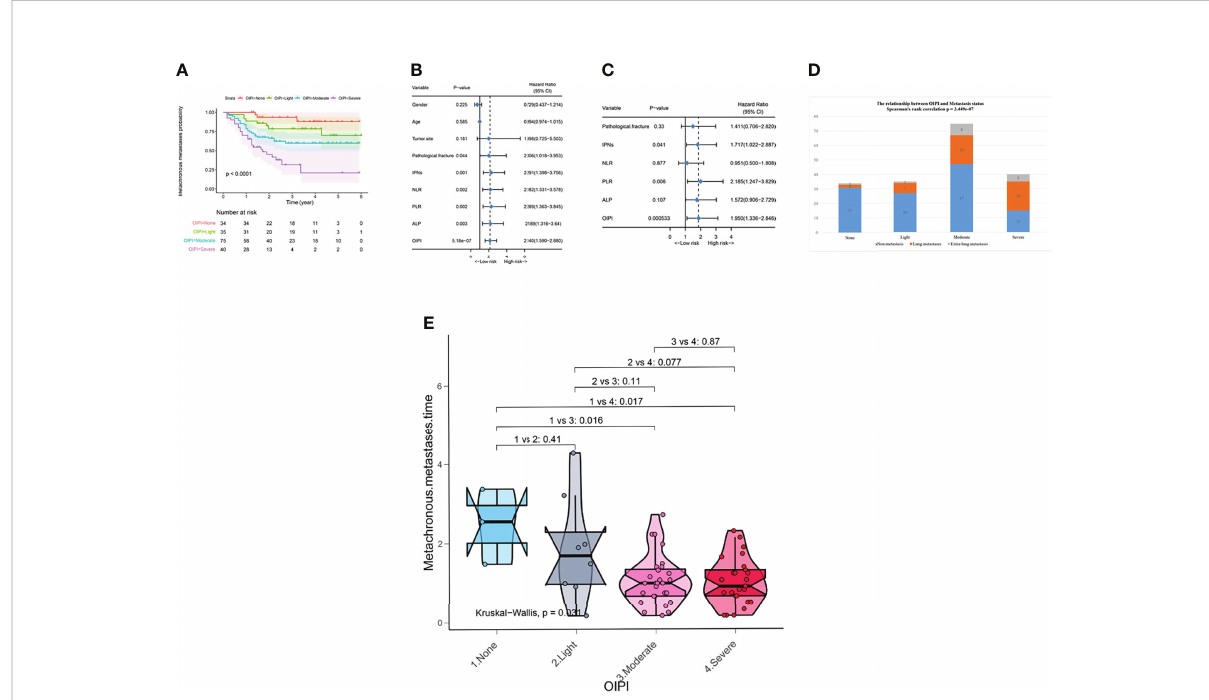
FIGURE 2 Effect of the OIPI in predicting metachronous metastasis, metastatic sites, and metastatic time in 184 patients. (A) OIPI divided 184 osteosarcoma patients into four groups. According to the logistic regression analysis, the differences between four OIPI groups in the metachronous metastasis probability were signi fi cant. (B) Forest plot showing the results of univariate Cox regression analysis of hematological markers and clinical features in 184 osteosarcoma patients. (C) Forest plot showing the results of multivariate Cox regression analysis of hematological markers and clinical features in 184 osteosarcoma patients. (D) Spearman ’ s rank correlation test demonstrated that OIPI was related to metastatic sites. (E) Kruskal – Wallis test demonstrated that there was a difference in metastatic time among four groups (P = 0.031). Patients in moderate and severe OIPI groups developed metachronous metastasis earlier than that of the no-OIPI group (P = 0.016 and P = 0.017, respectively). OIPI, osteosarcoma immune prognostic index; IPNs, indeterminate pulmonary nodules; NLR, neutrophil – lymphocyte ratio; PLR, platelet – lymphocyte ratio; ALP, alkaline phosphatase; OIPI, osteosarcoma immune prognostic